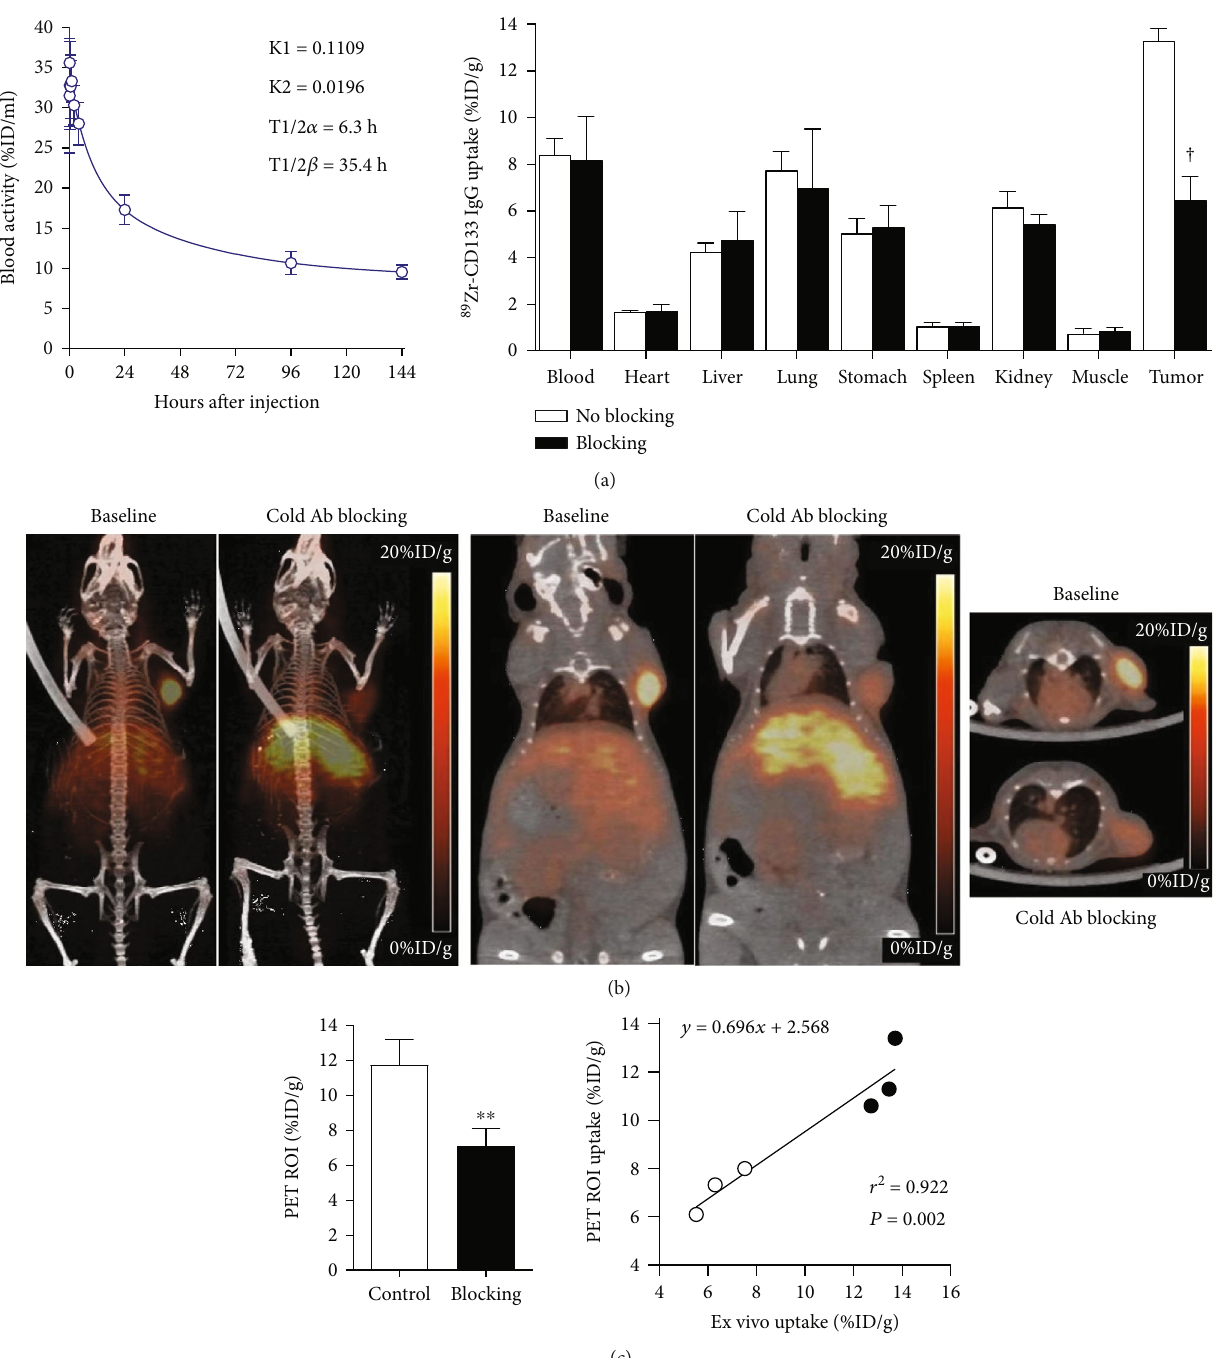
Figure 3: 89 Zr-CD133 IgG biodistribution and PET in mice. (a) Time-dependent blood clearance of 89 Zr-CD133 IgG following intravenous injection in normal Balb/c mice (left) and 6-day biodistribution in HT29 tumor-bearing Balb/c nu mice with or without excess cold anti- CD133 IgG (right). The blood clearance curve was fi tted with two-phase exponential decay nonlinear regression to obtain early and late rate constants (K1 and K2) and half-lives (T1/2 α and T1/2 β ). (b) Representative maximal intensity projection (left) and coronal (middle) and transaxial (right) PET images at 6 days postinjection in tumor-bearing mice with or without excess cold IgG. (c) PET image-based tumor uptake level (left) and correlation between PET image-based and ex vivo count-based tumor uptake levels (right). All data are mean ± SD of %ID/g obtained from fi ve (blood clearance) or three mice per group (biodistribution and PET). ∗∗ P < 0 : 01 , † P < 0 : 005 , compared to tumor uptake in the absence of excess cold